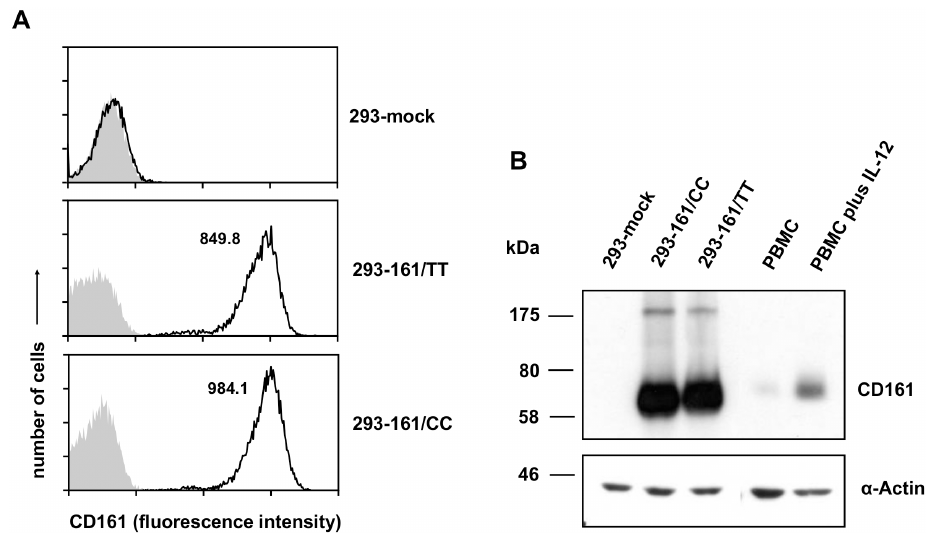
Fig 2. Characterization of 293 transfectants. 293 cells were “ mock ” -transfected with the empty pIRES2-AcGFP1 vector or vectors containing CD161 from a homozygous TT or CC individual. Analyses were performed after selection of stable transfectants. (A) Flow cytometry analysis of 293-mock, 293-CD161/TT, and 293-CD161/CC cells after staining with the PE-conjugated anti-CD161 mAb B199.2. Grey histograms represent staining with an isotype control mAb. The numbers represent mean fluorescence intensity obtained by anti-CD161 staining. (B) Detection of CD161 by Western-blotting. 293 transfectants were lysed, and protein lysates were separated by 9% SDS-PAGE. After transferring to PVDF membranes, samples were probed with the anti-CD161 mAb (B199.2). Binding of B199.2 was visualized by HRP- conjugated goat anti-mouse-IgG and ECL reagents. Protein loading was controlled by staining with a mAb against α -Actin. Representative results of at least two independent experiments are shown. Lysates of